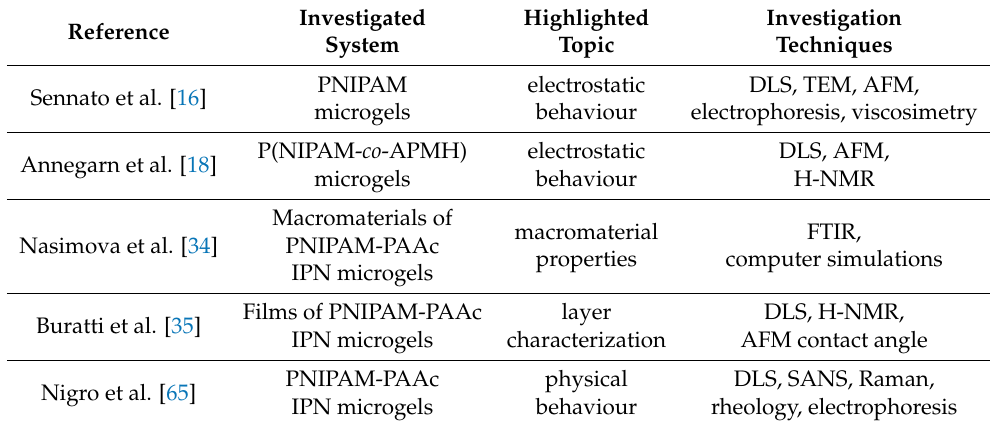
Table 1. Table of the articles published in Polymers in 2021 about PNIPAM based